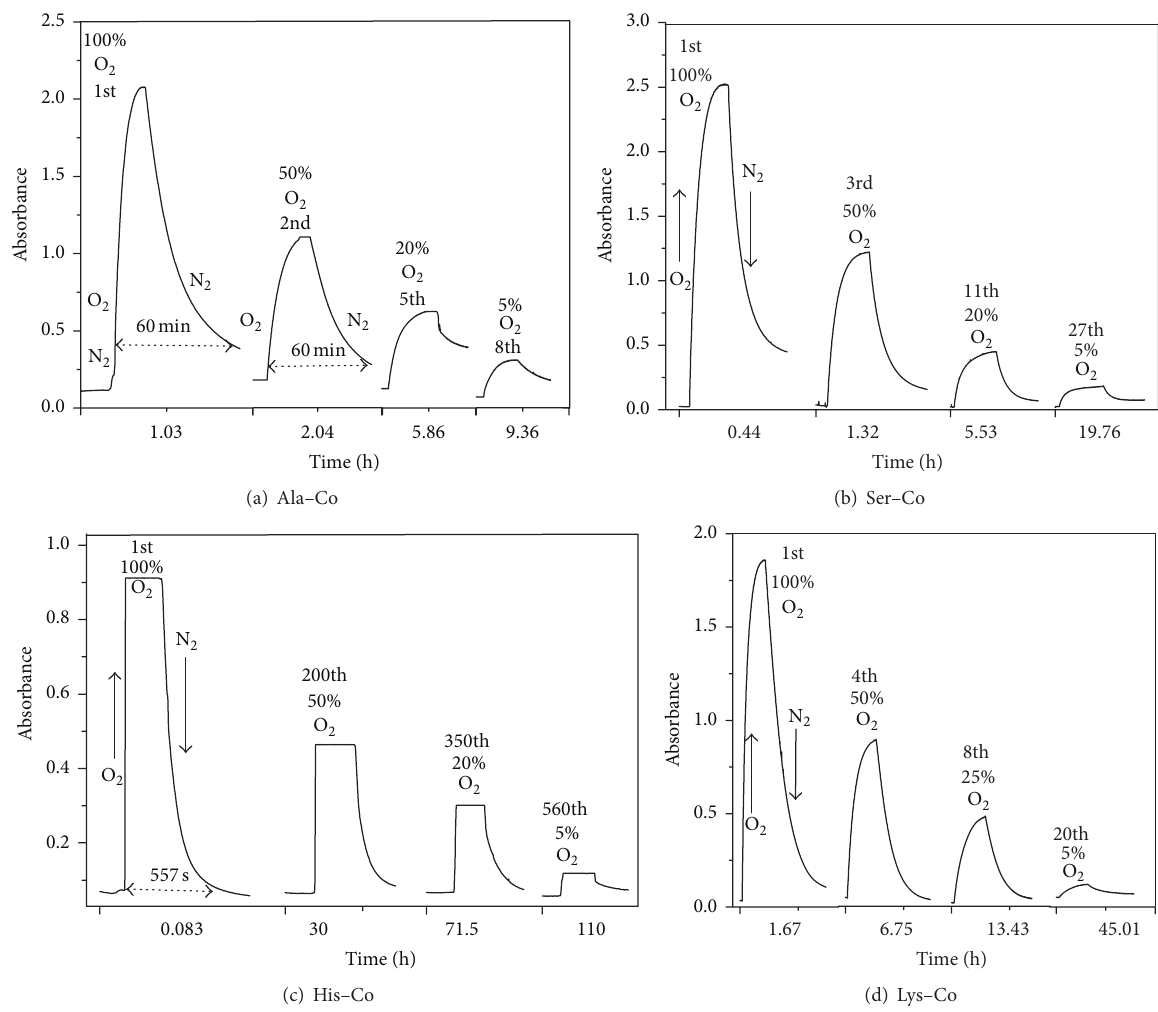
Figure 2: Absorbance changes at 𝜆